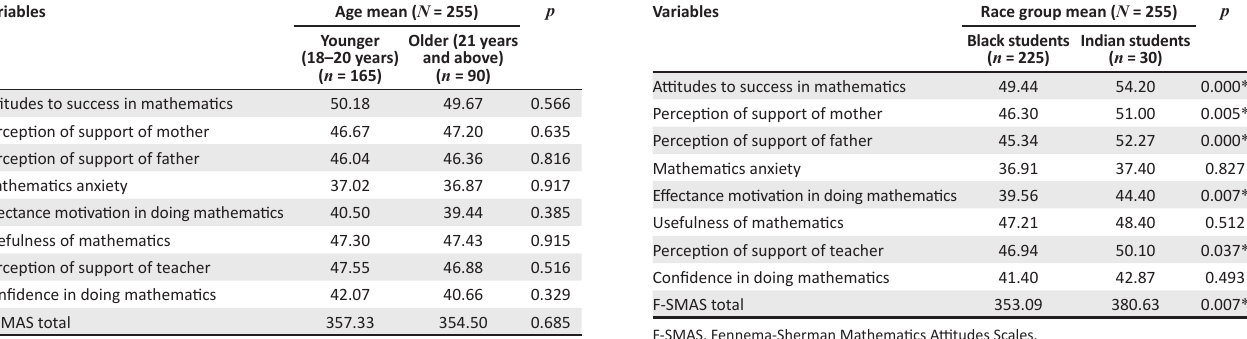
TABLE 2: Differences in attitudes towards mathematics between younger and older students. Variables